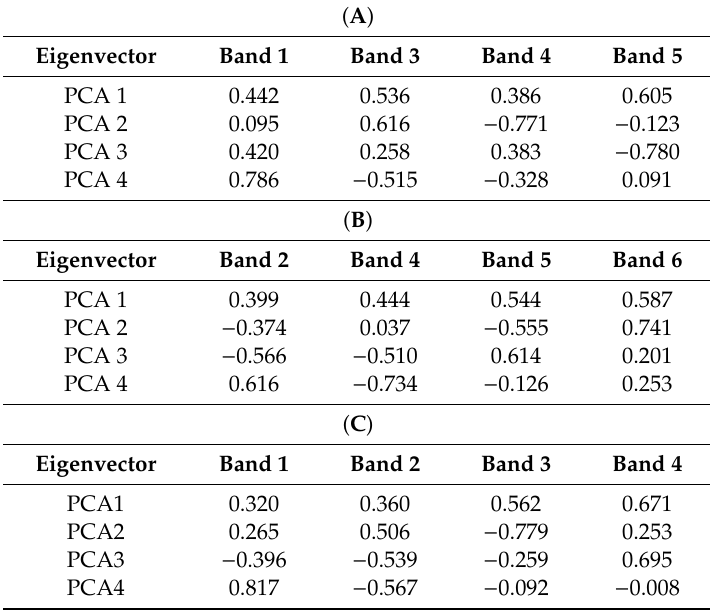
Table 3. The Eigenvector matrix values derived from principal component analysis (PCA) for mapping iron oxide / hydroxides. ( A ) Bands 1, 3, 4 and 5 of Landsat-7 ETM + ; ( B ) Bands 2, 4, 5 and 6 of Landsat-8; and ( C ) Bands 1, 2, 3 and 4 of